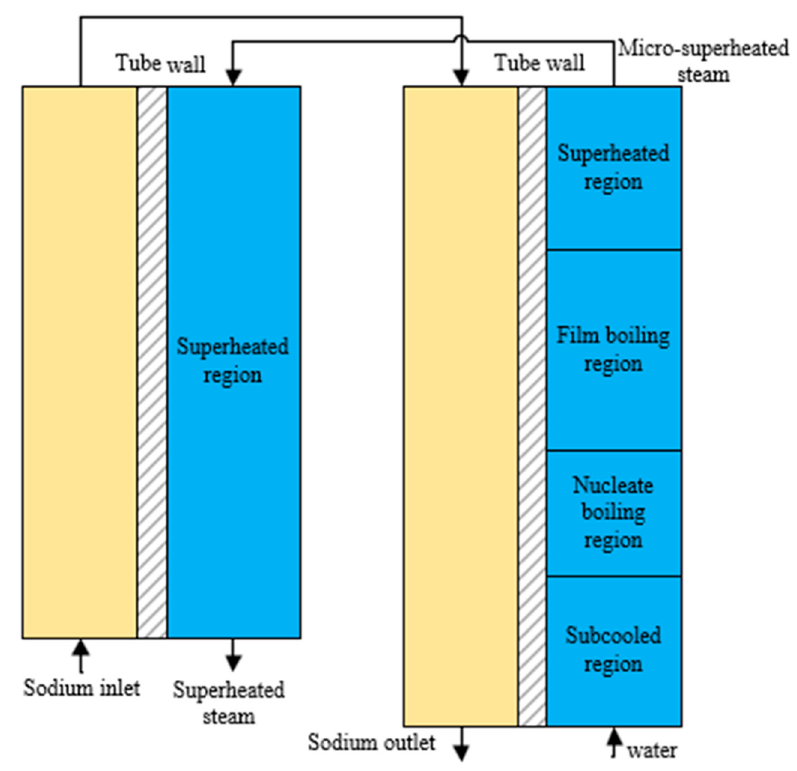
Figure 2. The OTSG heat transfer tube model.